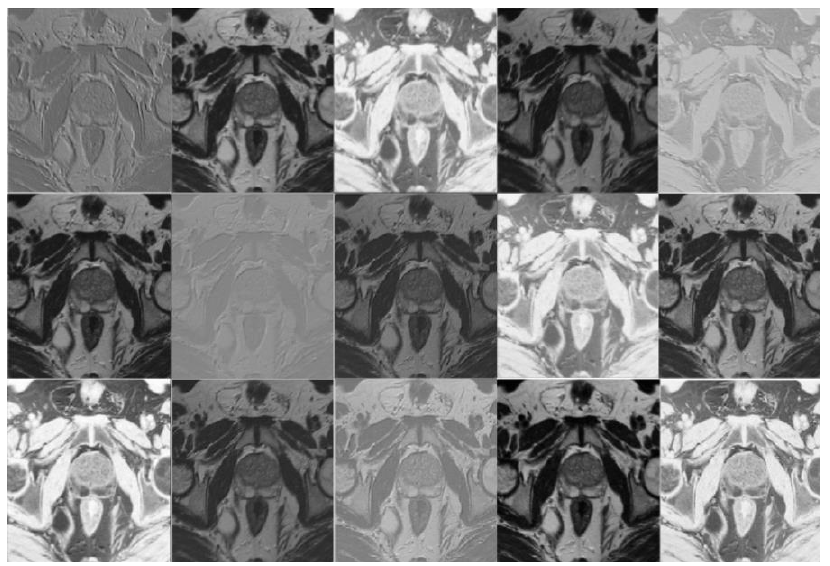
Table 2. The model parameters and shape output after the first hidden layer in the ENet model for a given provided input image (Patient #7 slice #20).